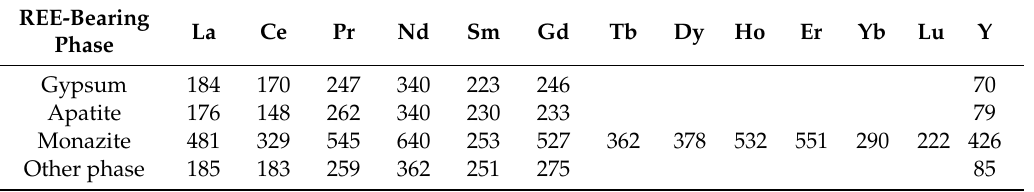
Table 2. The limits of detection (LODs) of the EPMA for REEs with sample phosphogypsum (PG) (mg / kg).